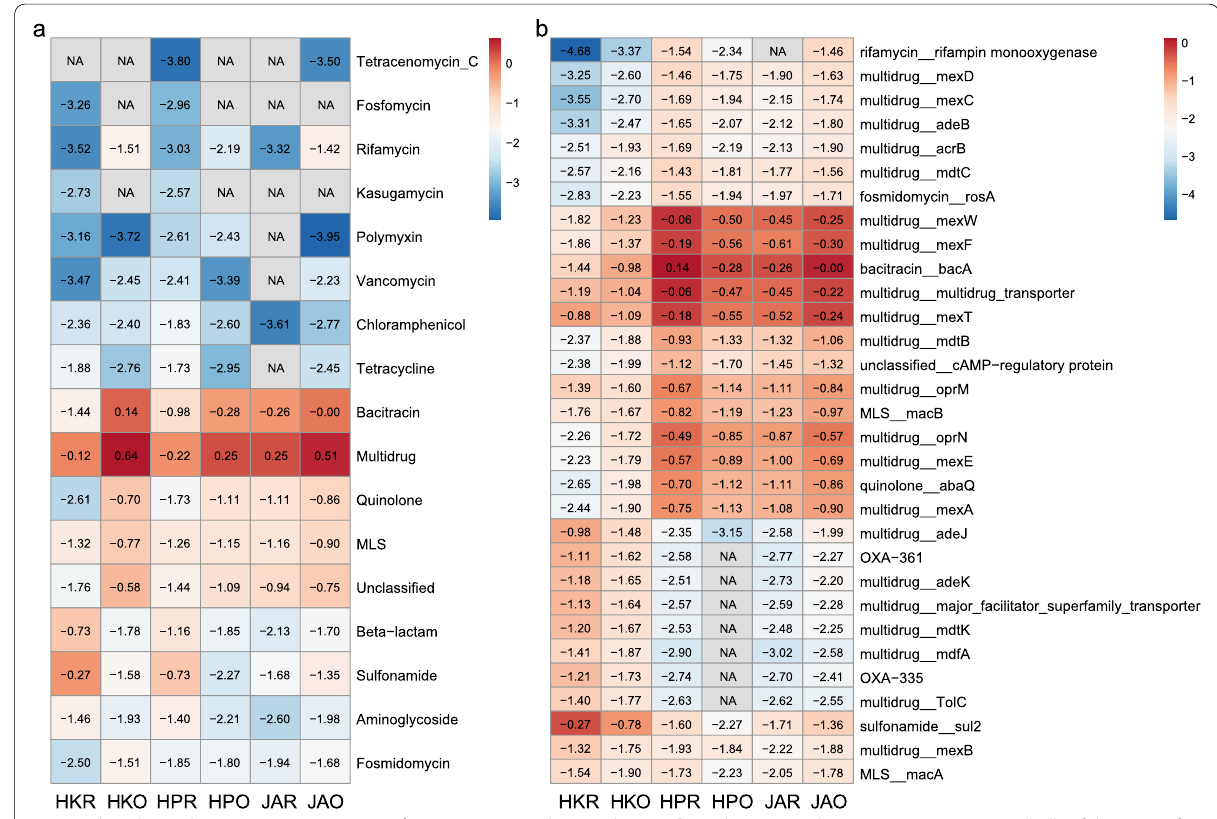
Fig. 4 Abundance [log 10 (copies/16S rDNA)] of ARG types ( a ) and ARG subtypes ( b ) in the six sampling sites (waste reception halls of three transfer stations: HKR, HPR, JAR; top vents of three transfer stations: HKO, KPO, JAO). ARG Subtypes listed only 31 species with a sum of abundances greater than 0.05 copies/16S rDNA. MLS: Macrolide-Lincosamide-Streptogramin. NA: not